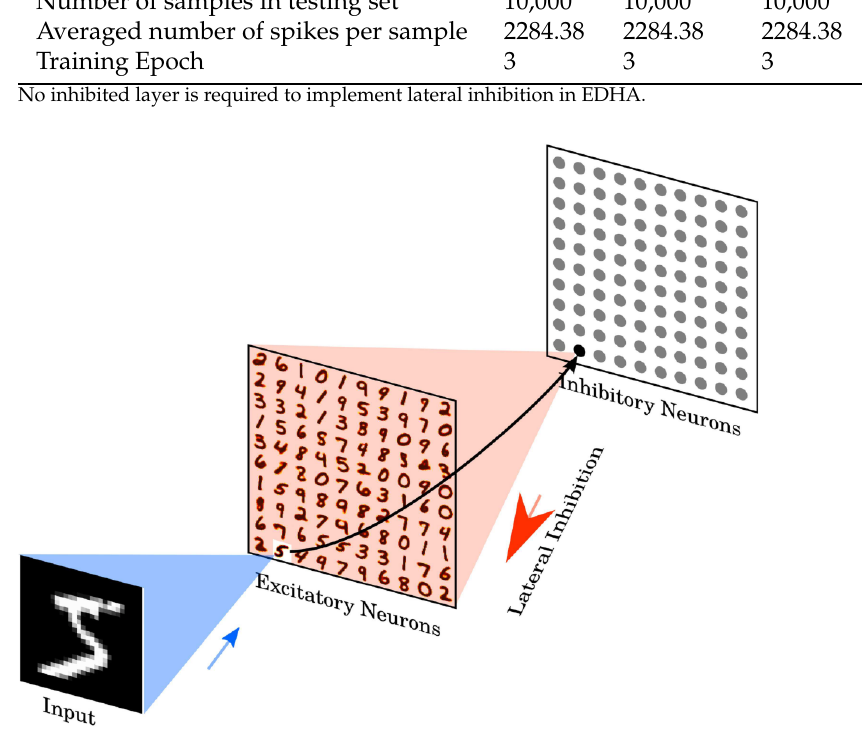
Figure 9. Network structure of Deihl’s work